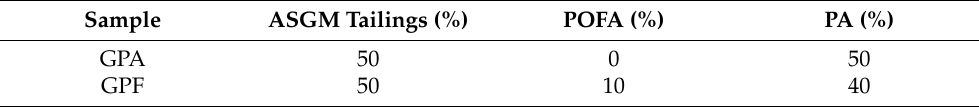
Table 1. Geopolymer composite mixing